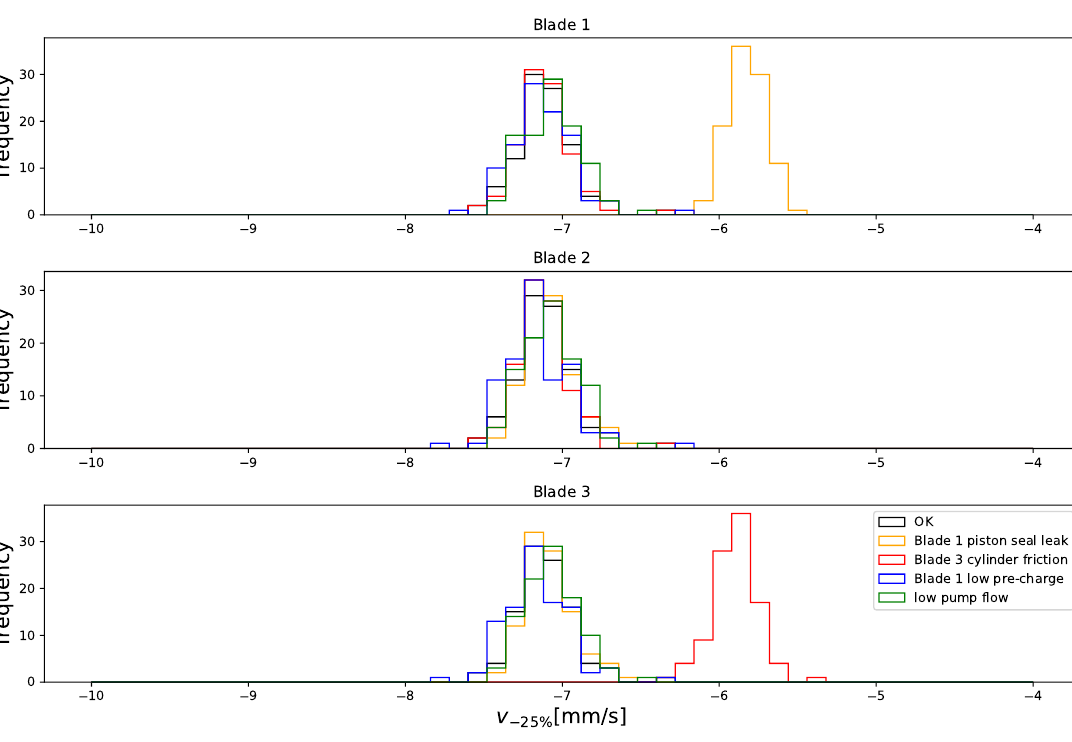
Figure 20. Simulation parameter distribution, v + 25% .